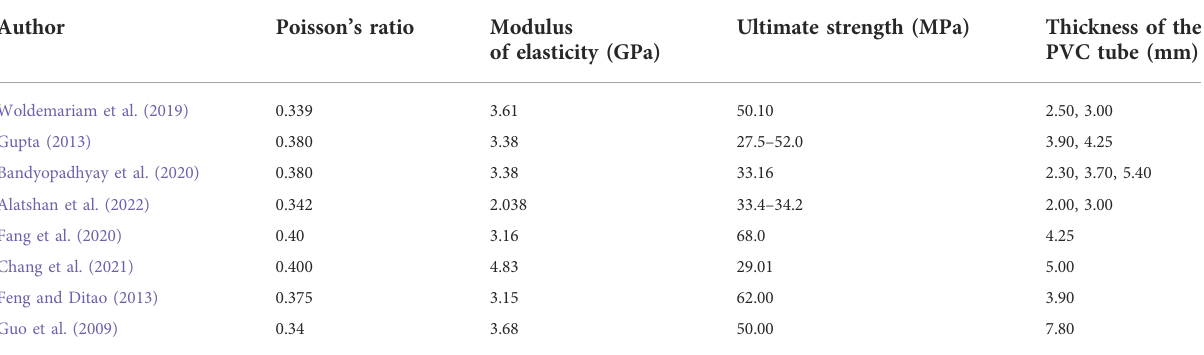
TABLE 3 Tensile properties of PVC.